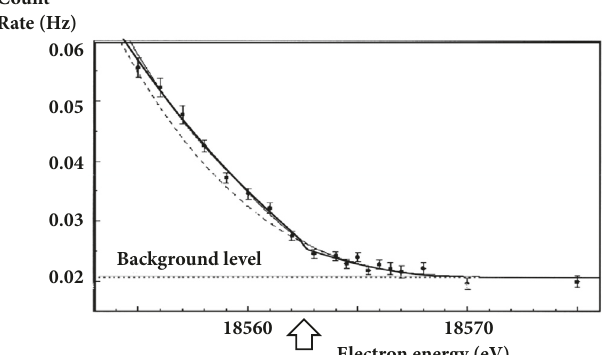
Figure 5: The published spectrum for the Troitsk Collaboration taken from [20]. The solid curve is this authors fit to the 3 + 3 model from [19] after an adjustment to the energy axis, which fits the data much better than the standard quadratic (dashed curve) for the zero mass case. The most recent (2012) Troitsk reassessment of their anomaly no longer regards it as statistically significant as discussed in the text and in more detail in [19].